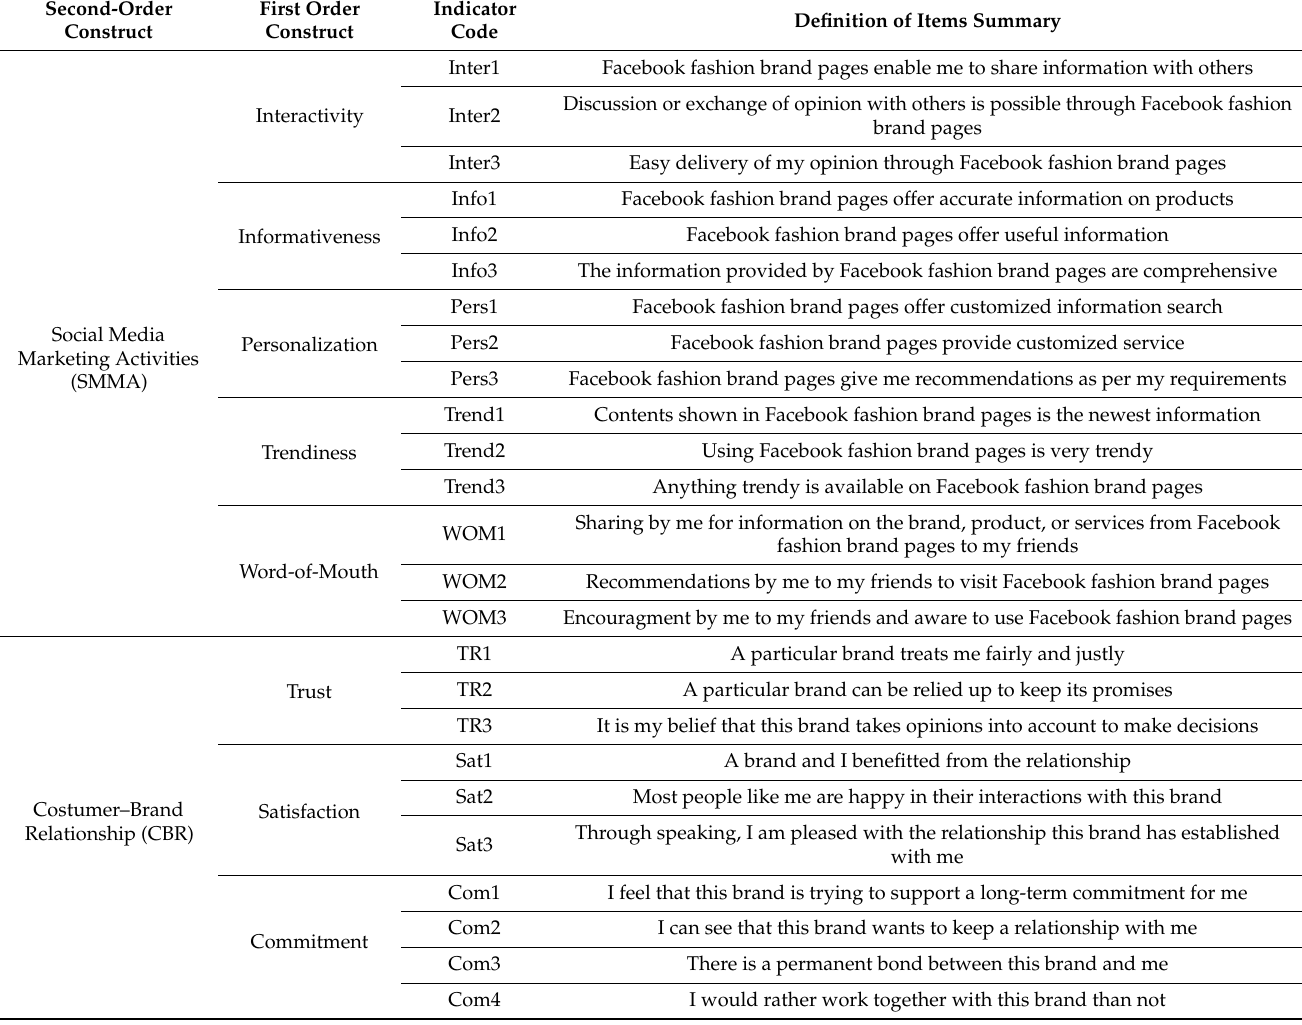
Table 1. Definitions of items